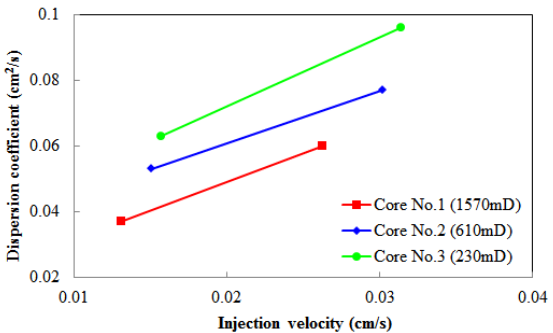
Figure 7. Dispersion coefficient versus injection (superficial) velocity in natural cores.